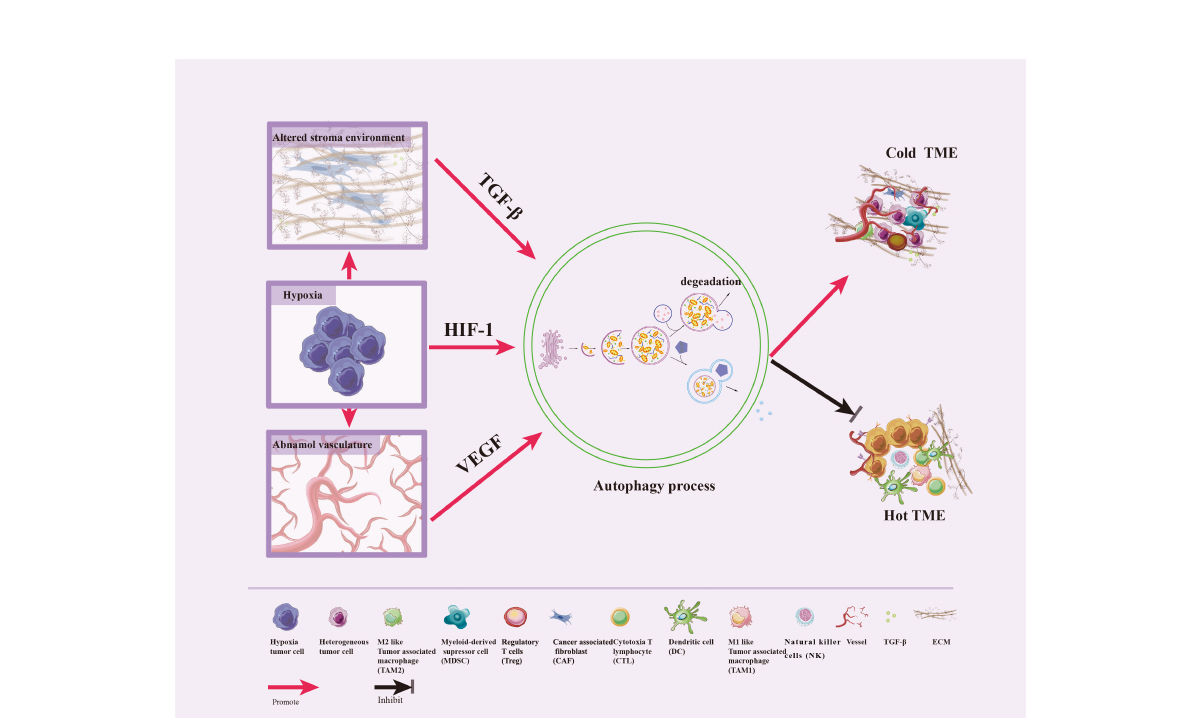
FIGURE 3 Crosstalk between autophagy and TME features. Hypoxic stress is a typical feature of TME, which triggers the abnormal vasculature and the alteration of the three-dimensional stromal environment. In response to these stresses, autophagy can be induced by HIF-1, VEGF, and TGF- b to promote tumor cell survival, enhance differentiation of normal fi broblasts to CAF, promote dense ECM formation, inhibit immune cells in fi ltration and vascular normalization, impair CTL and NK cell-mediated anti-tumor immune responses, and convert hot TME to